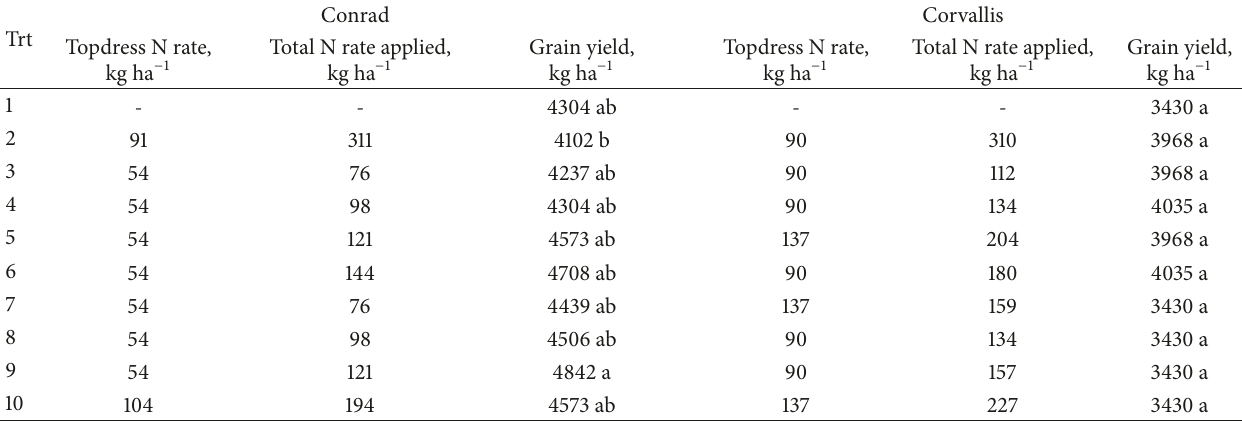
Table 5: Preplant N rate, topdress N rate, topdress N source, total N rate applied, and spring wheat grain yield, Conrad and Corvallis, MT, 2013. Trt